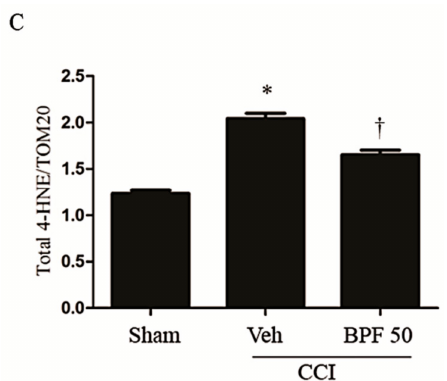
Figure 4. The development of hyperalgesia and allodynia coincided with an increase of 4-HNE level 21 days post injury. ( A ) CCI rats showed a significant production of 4-HNE in spinal cord 21 days post injury as measured by WES methodology. Subcutaneous infusion of BPF (50 mg / kg), concurrently with surgery (day 0), showed a significant reduction of these values. ( B ) No di ff erence for TOM20 expression was detected among the lanes in these conditions. ( A , B ) Lanes and ( D ) electropherogram are representative of results from 6 di ff erent animals. ( C ) Densitometric analyses of all animals per groups are reported. Results are expressed as mean ± SEM for 6 rats. * p < 0.05 versus sham; † p < 0.05 versus vehicle + CCI.